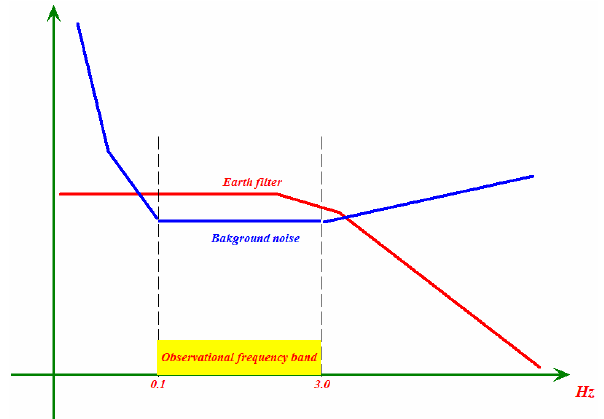
Fig. 3. Spectral window.